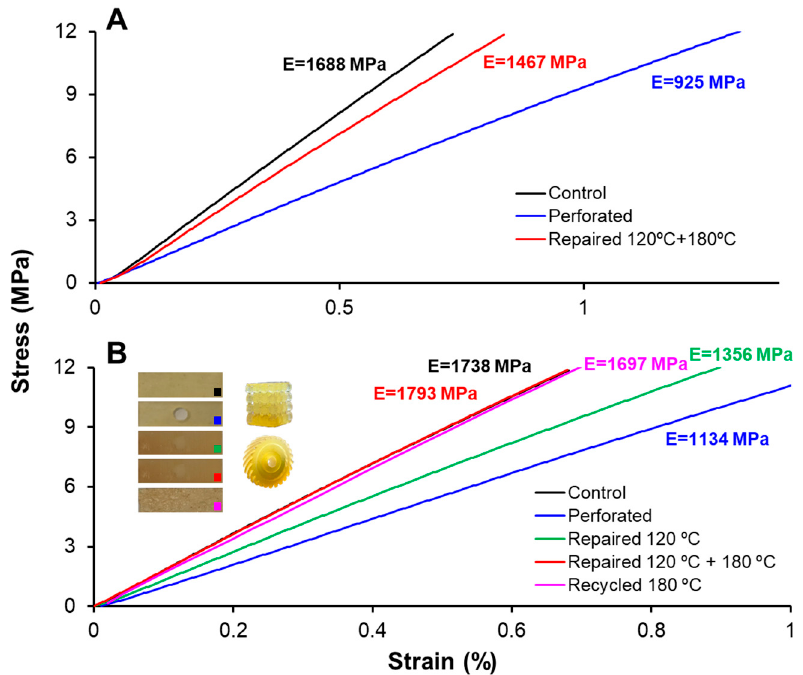
Figure 15. ( A ) The 3-point-bending stress–strain curves of pristine (black), perforated (blue), and repaired (red) FEMA 3D 25. ( B ) Stress–strain curves after repairing damaged samples of FEMA 3D 25 which were not post-treated at 180 ◦ C during manufacture. Inset: Tensile testing samples, color coded to match the curves (left), a zeolite structure (top right), and a toothed gear (bottom right) printed with FEMA 3D 25.